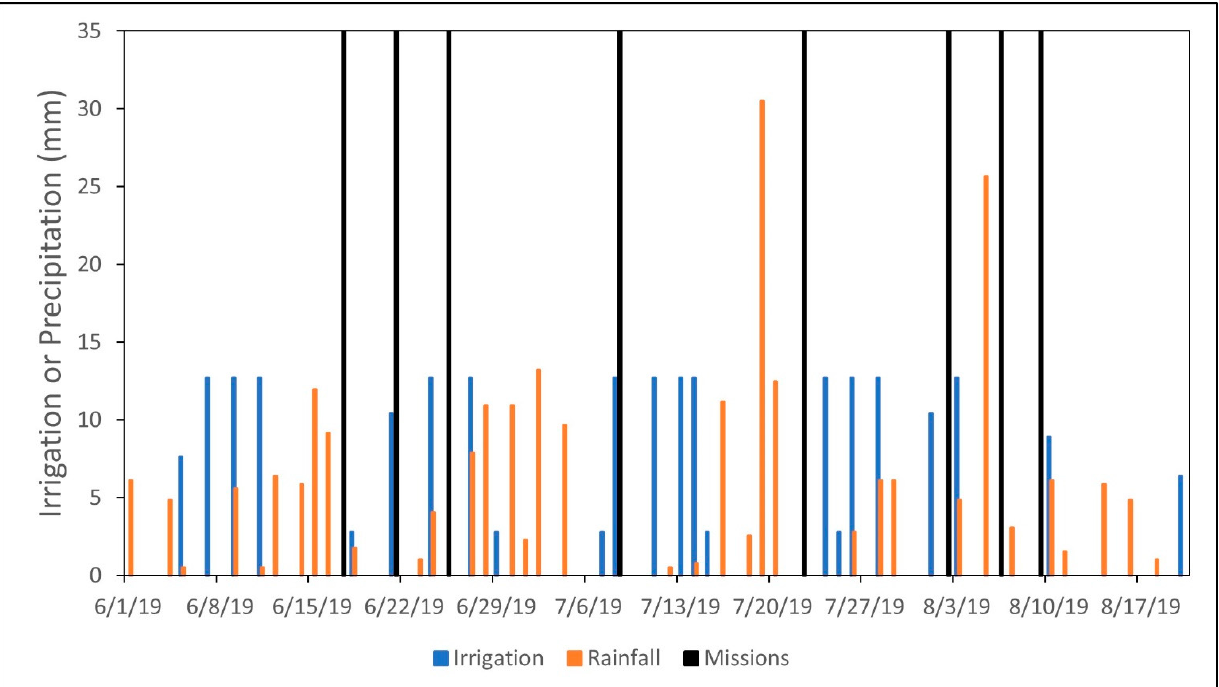
Figure 3. Growing season timeseries of irrigation (mm) and precipitation (mm) for 2019. Precipitation is in hourly increments and the timing of irrigation events are associated with the irrigation initiation (duration is not depicted). Mission sets are highlighted with black vertical lines. Imagery was not collected while the center pivot system was